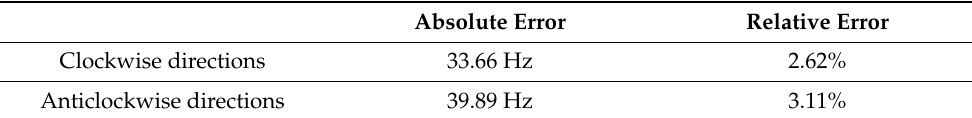
Table 3. Values of absolute and relative error; oscilloscope was used as a